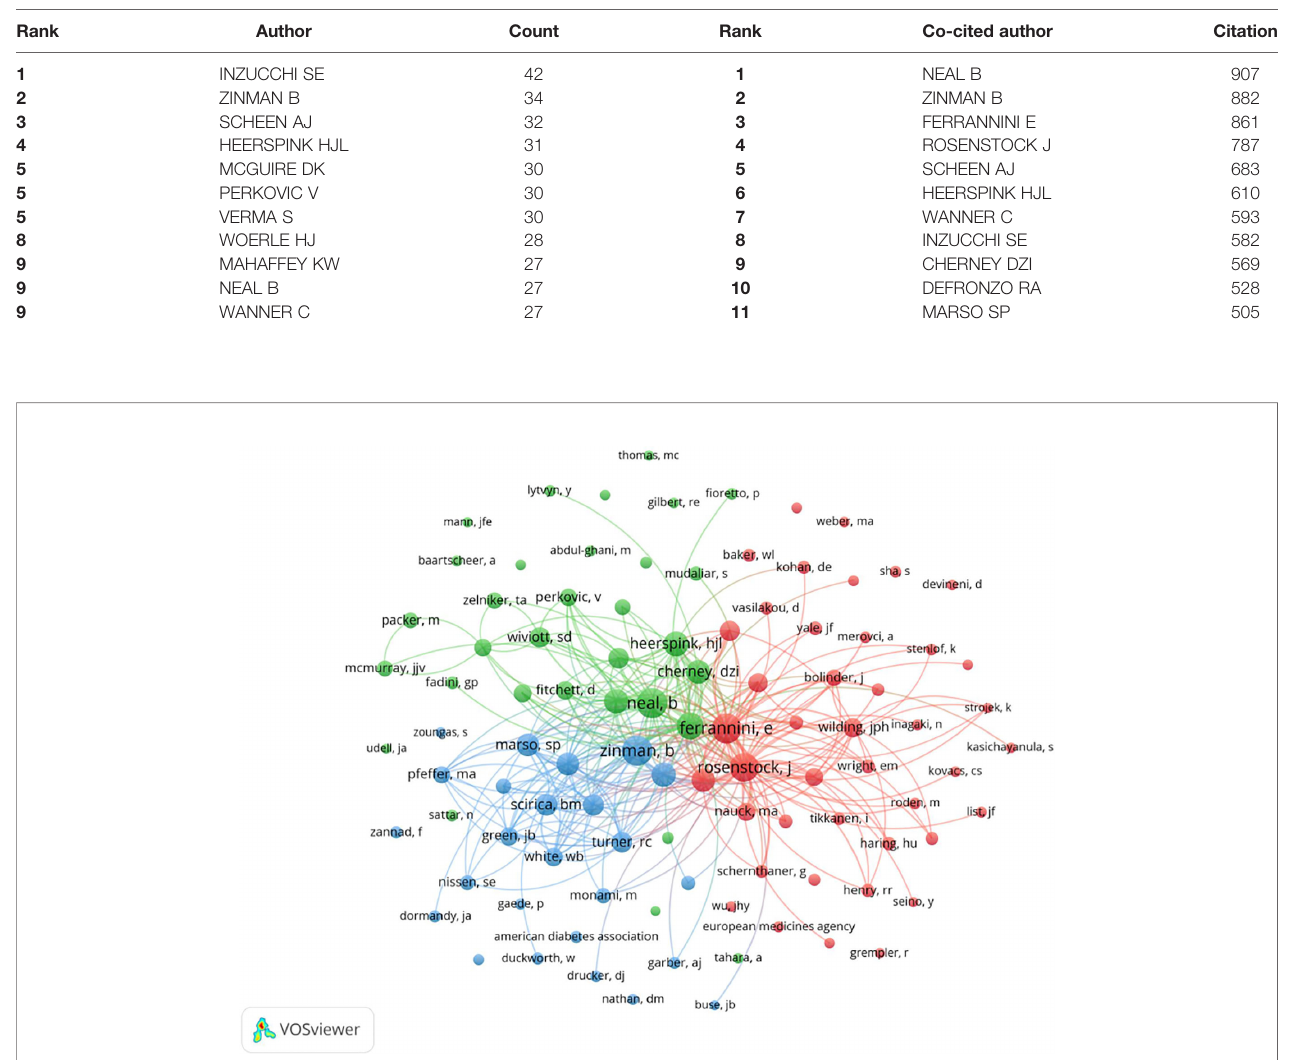
TABLE 3 | Top 11 productive authors and co-cited authors in SGLT2 inhibitors in CV research.